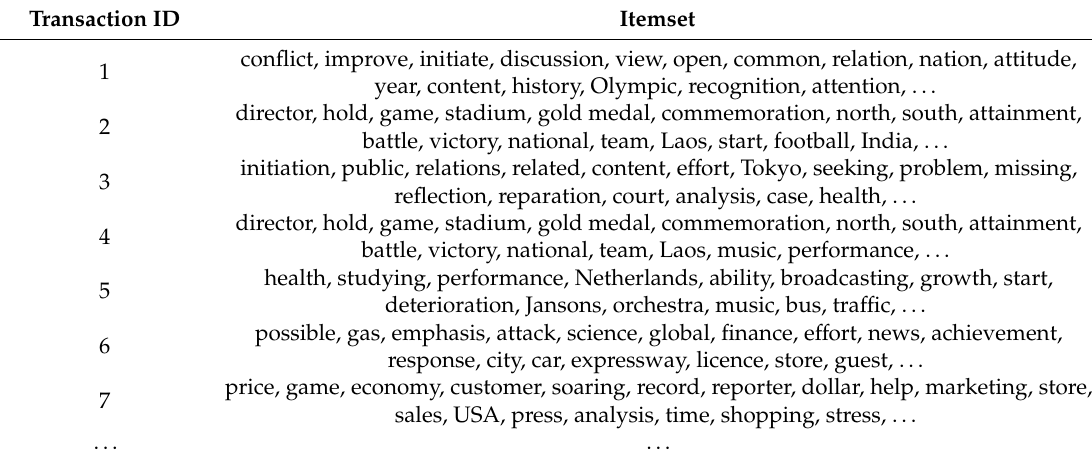
Table 3. Transaction Data after Preprocessing.